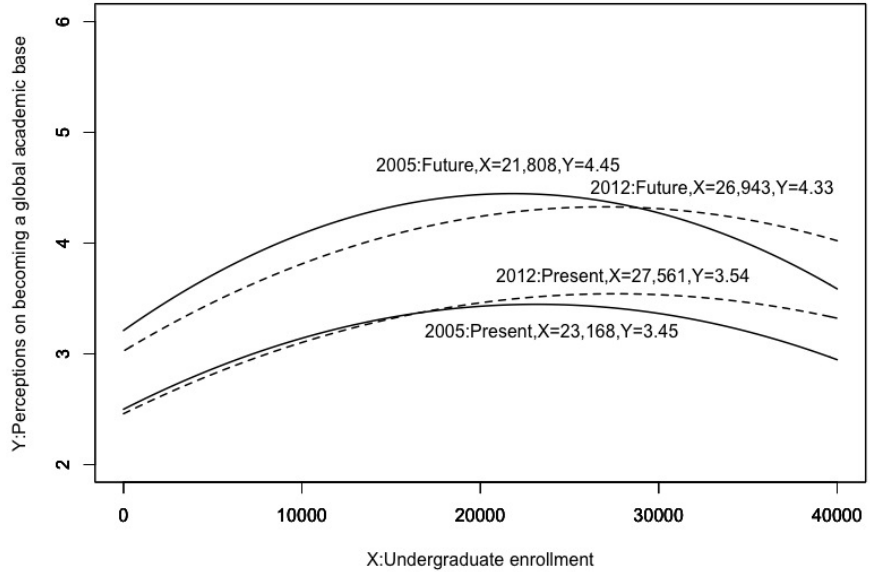
Figure 1. Self-assessment of Japanese university executives on becoming a global knowledge base and undergraduate